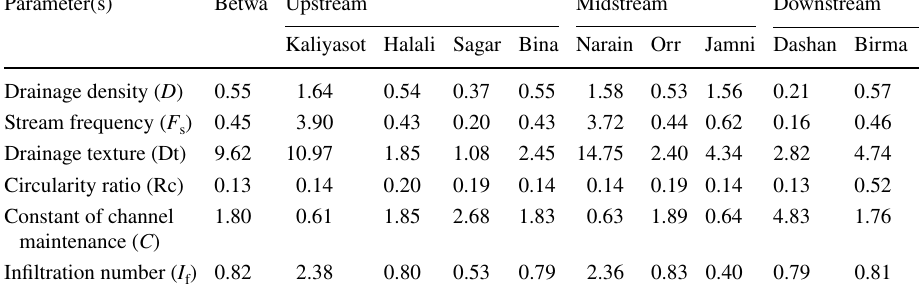
Table 5 Results of drainage texture analysis of Betwa River basin and sub-basins